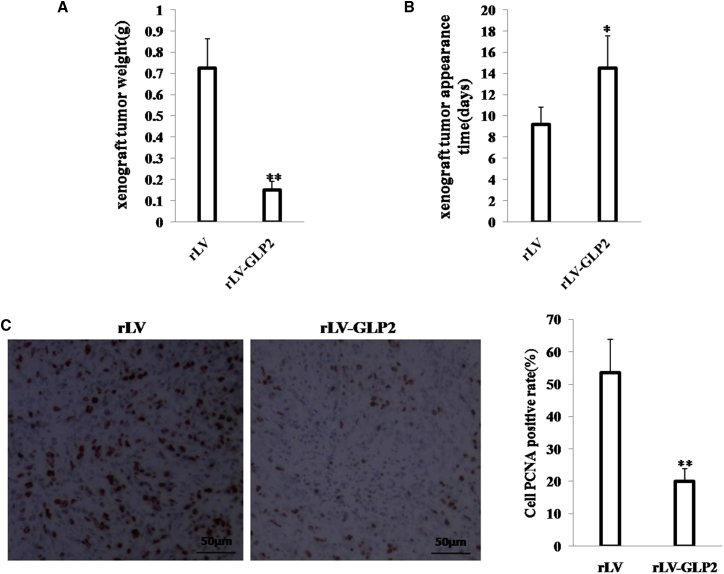
GLP2 Inhibits Osteosarcoma Carcinogenesis In Vivo(A) The xenograft tumors from BALB/c mouse injected with MG63 cells infected with rLV-GLP2 or rLV. subcutaneously at armpit. The xenograft tumors weight (gram) in the two groups. Data were means of value from ten BALB/c mice (mean ± SEM; n = 10; **p < 0.01). (B) The xenograft tumors appearance time in the two groups. Data were means of value from ten BALB/c mice (mean ± SEM; n = 10; *p < 0.05). (C) A portion of each xenograft tumor was fixed in 4% formaldehyde and embedded in paraffin, and the micrometers of sections (4 μm) were made for PCNA staining (original magnification × 100). **p < 0.01.